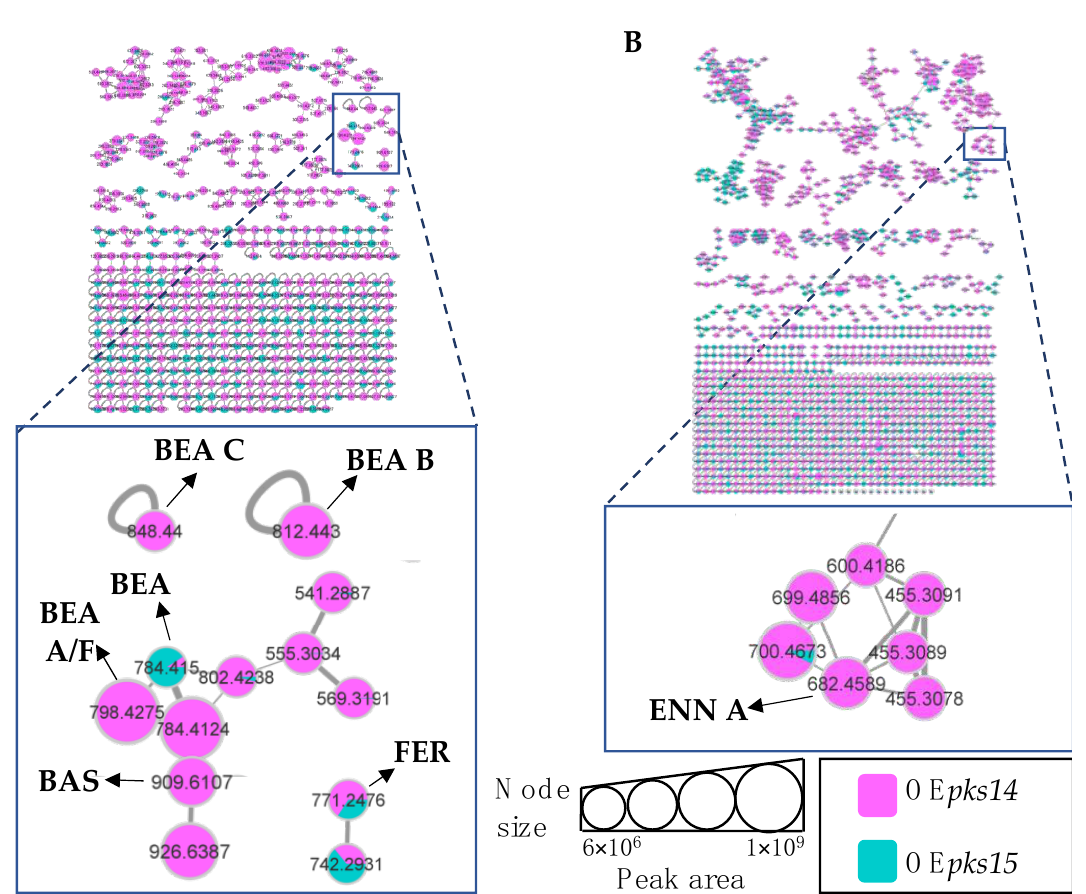
Figure 6. Molecular networking of insect-virulence metabolites and a siderophore from OE pks14 (pink) and OE pks15 (green) strains in culture identified beauvericin (BEA) and ferricrocin (FER) from both strains. ( A ) Beauvericin A/F (BEA A/F), beauvericin B (BEA B), beauvericin C (BEA C), and bassianolide (BAS) were found exclusively from OE pks14 cells. ( B ) Enniatin A (ENN A) was found exclusively in OE pks14 culture broth. Node sizes represent the sums of chromatographic peak areas, and pie charts indicate chromatographic peak-area proportions for the detected insect virulence factors.